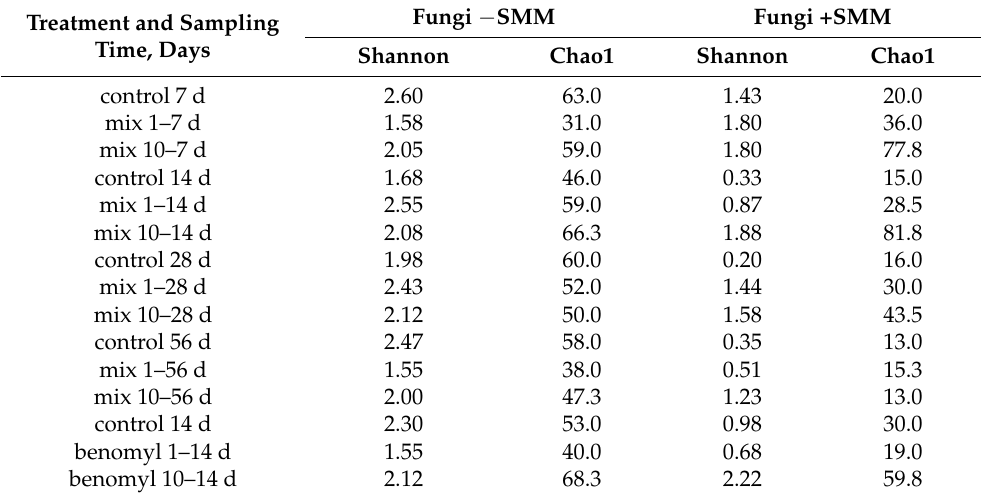
Table 6. Indices of the alpha diversity of the fungal community at the genus level in all variants of the experiment. Treatment and Sampling Time,